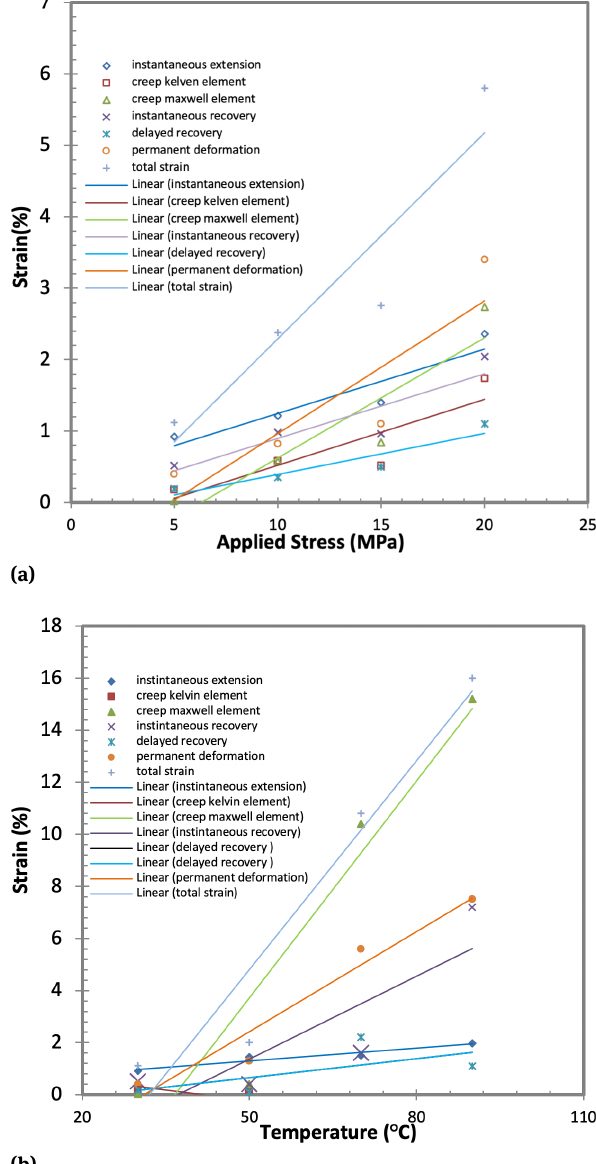
Figure 3: Variation of creep parameter of epoxy with (a) Applied stress, (b)